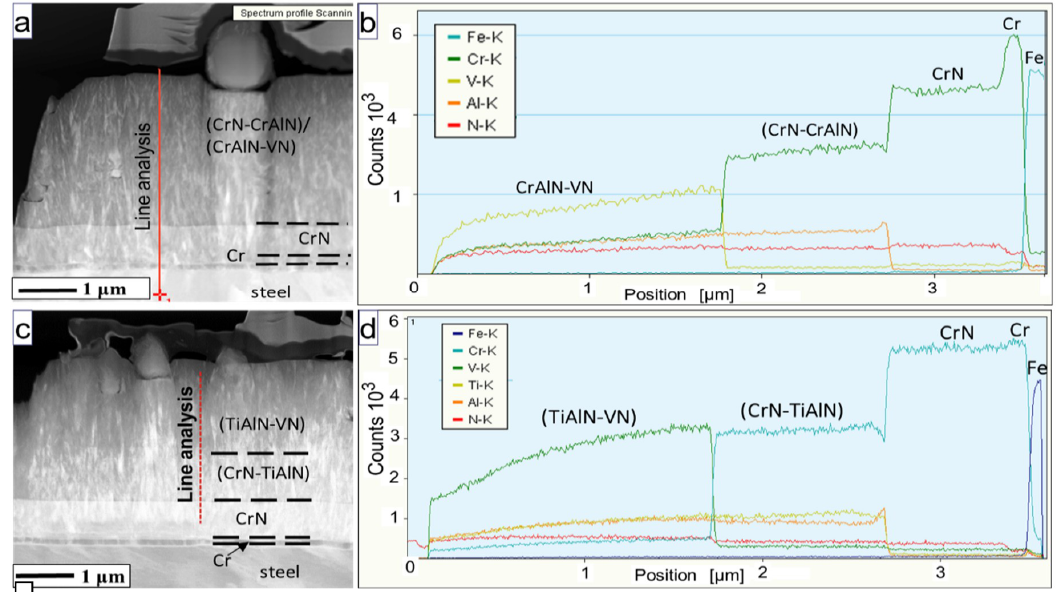
Figure 4. Scanning Transmission Electron Microscopy/ High Angle Annular Dark Field STEM/HAADFI mages of cross-section of all the P1 ( a,b ) and P2 ( c,d ) hybrid coatings with accompanying EDS profiles presenting distribution of Cr, Al, Ti, V, N and Fe.